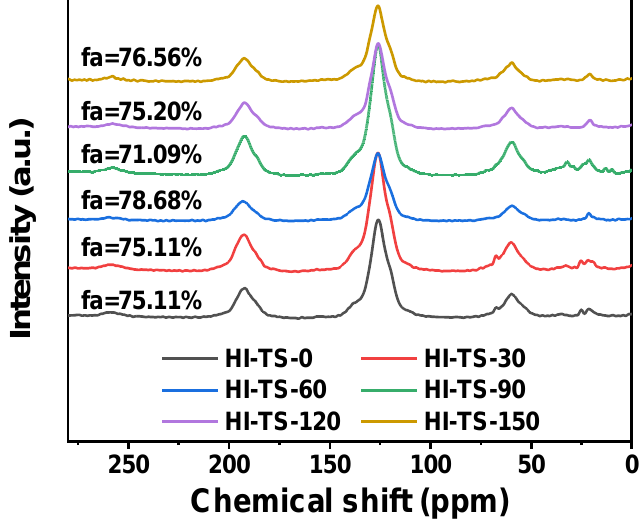
Figure 5. The 13 C − NMR of the HI − TS fraction in spinnable pitch at different incubation days.